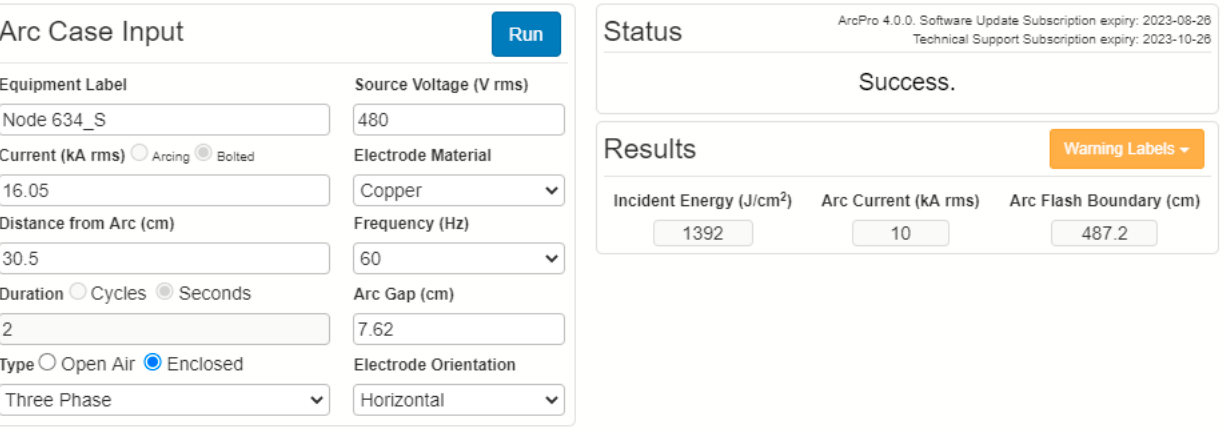
Figure 12. ArcPro simulation results—Case study 4. Table 9. ArcPro simulation results summary—Case study 4.